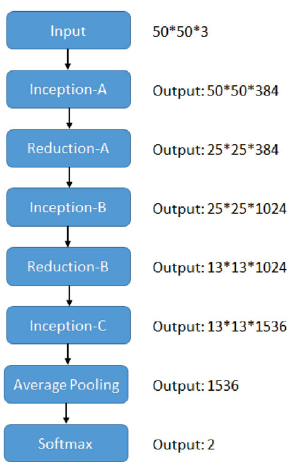
Fig. 4 Modified Inception network structure.